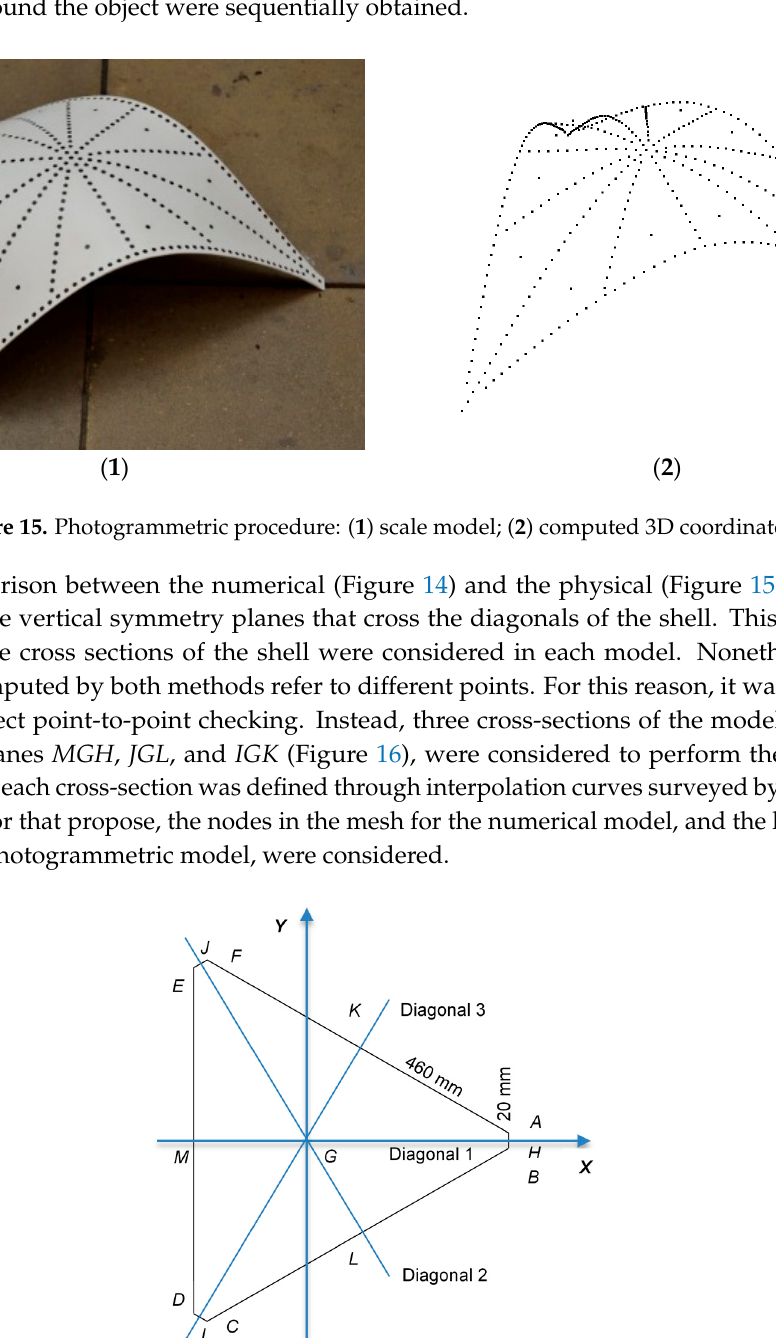
Figure 17. Diagonal cross-section defined by the plane MGH : Finite Element Method (FEM) vs. Photogrammetry curves. Figure 18. Diagonal cross-section defined by the plane JGL : Finite Element Method (FEM) vs. Photogrammetry curves.